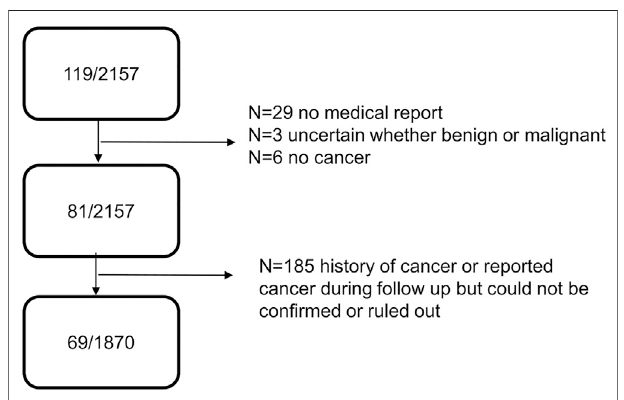
FIGURE 1 | Flow chart cancer cases